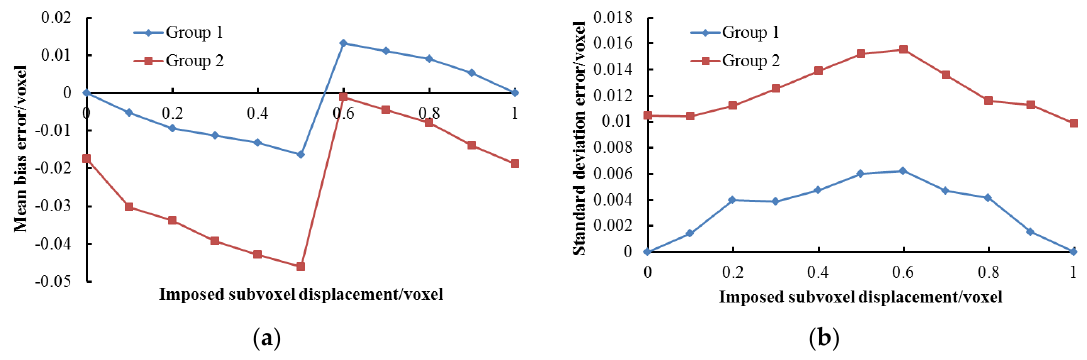
Figure 14. Influence of noise and artifacts on the imposed subvoxel displacement measurement ( a ) Mean bias error of displacement; ( b ) Standard deviation error of displacement.